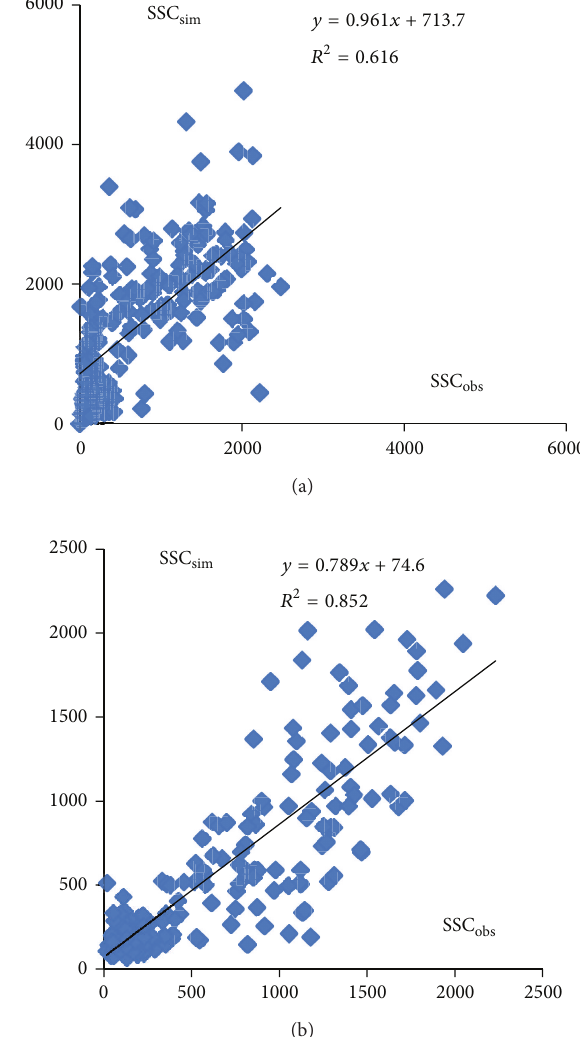
Figure 7: Scatterplot of observed and simulated monthly SSC from SWAT (a) and new sediment rating curve (b) in the Laichau station.